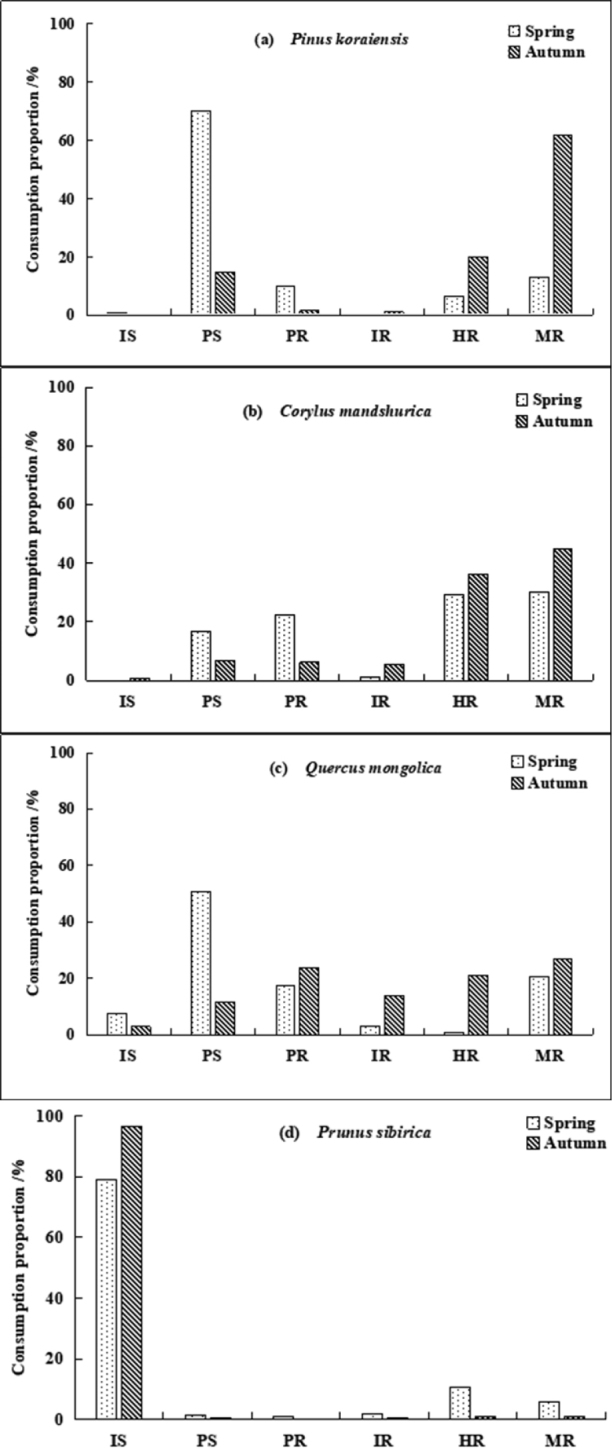
Statistics on the fate of the four types of seeds combined in spring and autumn in temperate forests of Northeast China. Abbreviations: IS–Intact in situ, PS–Predation in situ, PR–Predation after removal, IR–Intact after removal, HR–Hoarded after removal, MR–Missing after removal.